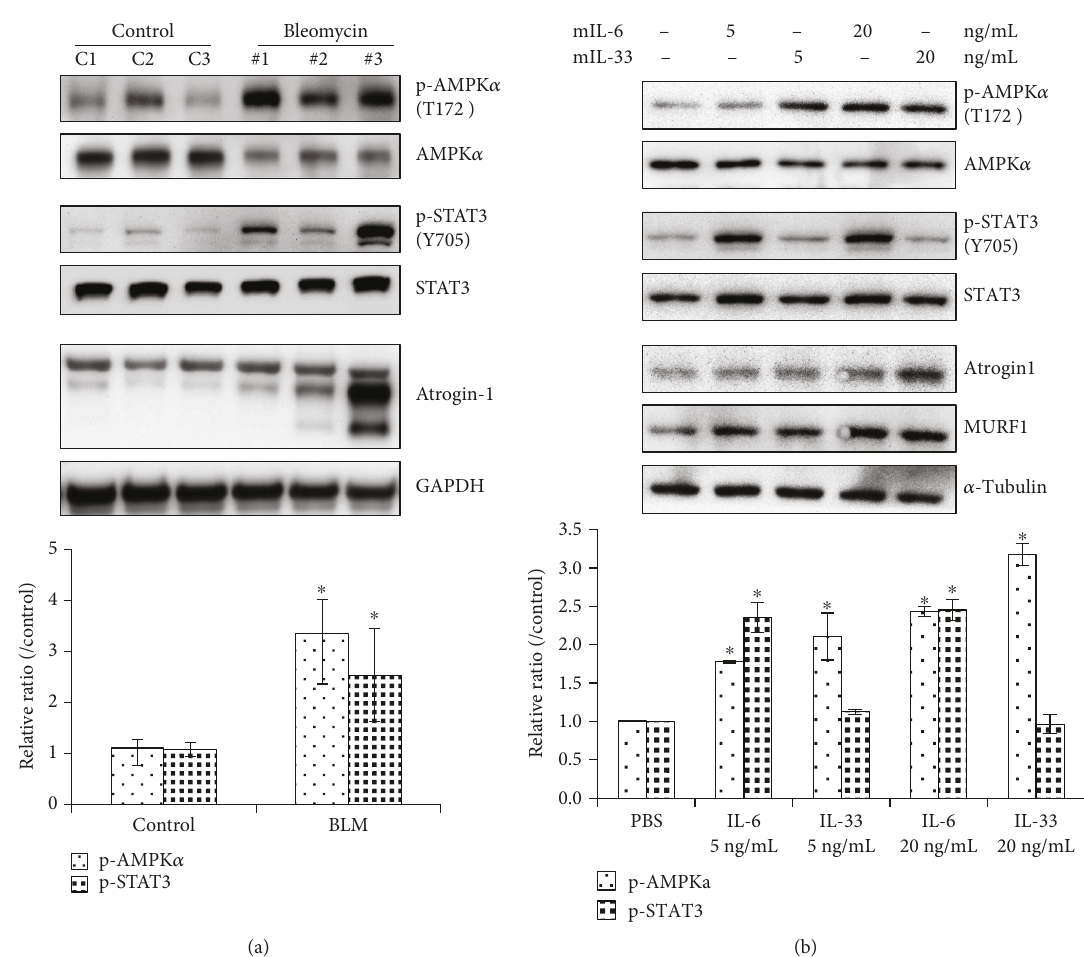
Figure 6: IL-6 and IL-33 may synergistically cause muscle atrophy. (a) The quadriceps muscle of the mice was homogenized, and the lysate was analyzed by Western blotting with speci fi c antibodies against STAT3, AMPK, and Atrogin-1. (b) C2C12 cells, mouse adherent myoblasts, were incubated with 2% horse serum for 72 hours and stimulated with recombinant mouse IL-6 and IL-33 in serum-free medium as indicated for 24 hours. The remaining cells were harvested, and the levels of p-STAT3, STAT3, p-AMPK α , and AMPK α in the cell lysate were analyzed by Western blotting. α -Tubulin and GAPDH were used as internal controls. The intensity of bands in the Western blots was measured by ImageJ software. The quantitative data were expressed as the means ± SD . ∗ p < 0 05 compared with